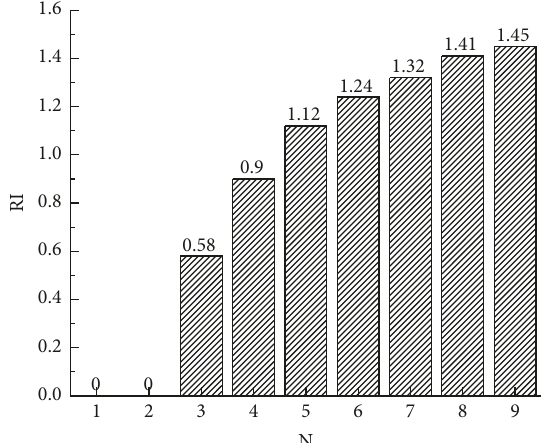
Figure 5: Average stochastic consistency indicator.